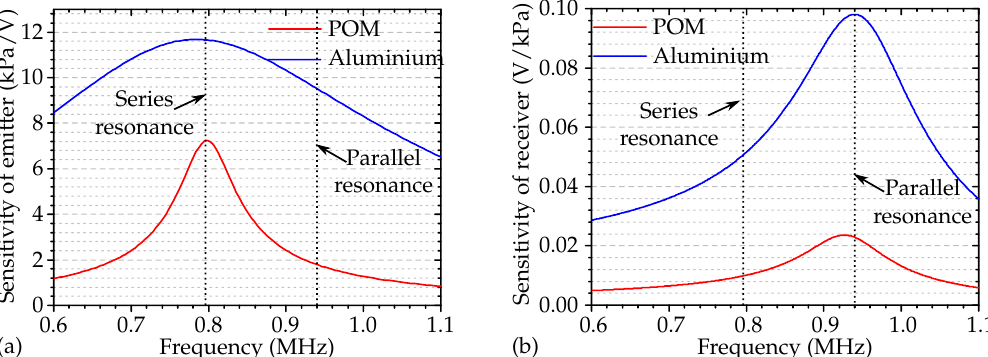
Figure 5. ( a ) Emission transfer function and ( b ) receiving transfer function of the transducer, for aluminium and POM as the transmitting